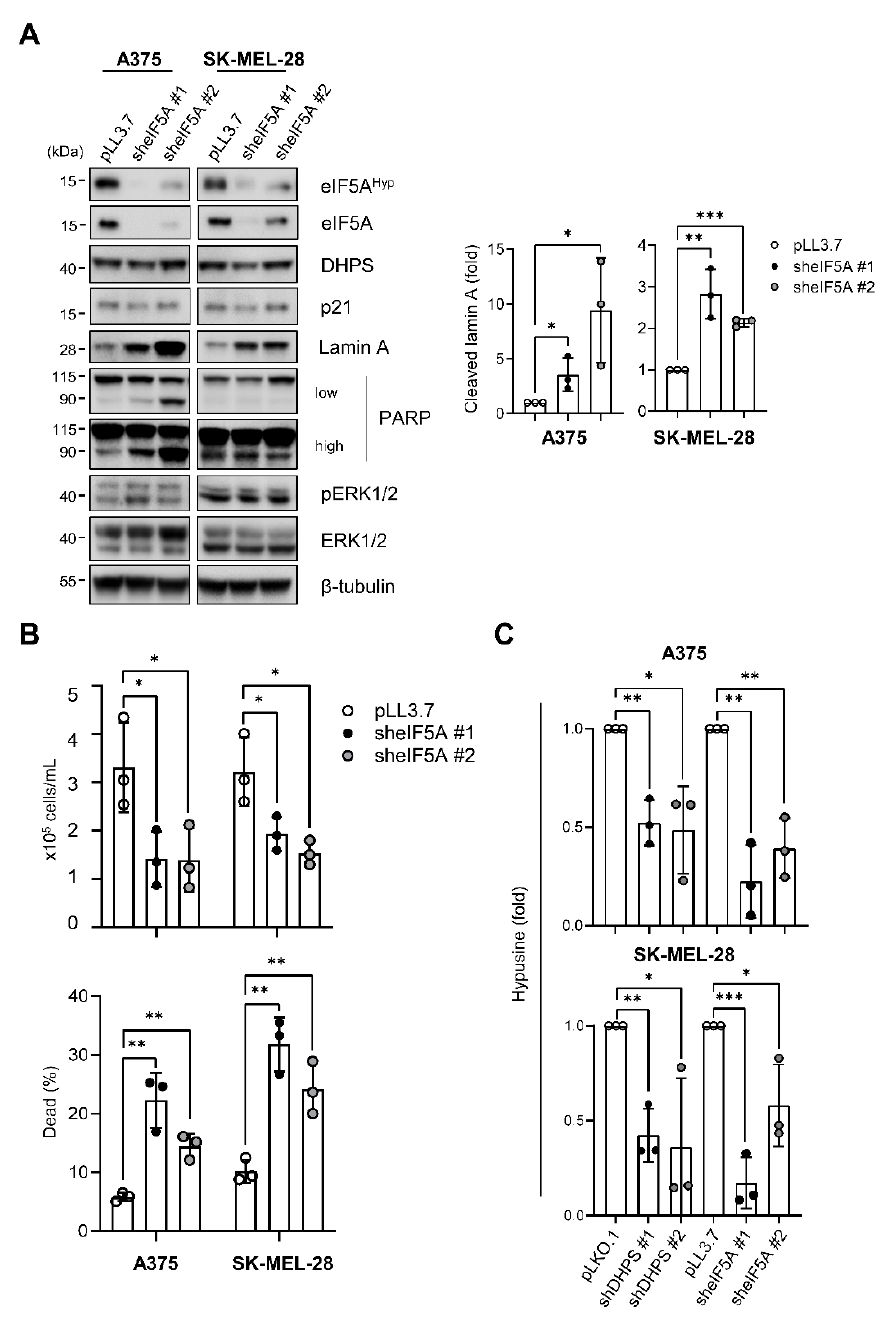
Figure 2. Knockdown of eIF5A induces cell death in A375 andSK-MEL-28 cells. ( A ) Western blots of total lysates of cells infected for 4 days with pLL3.7 viruses expressing shRNA targeting different regions of EIF5A mRNA (sheIF5A #1 and sheIF5A #2). β‐ tubulin is the control for equal protein loading. Empty virus was used as a control. (right) Densitometry of cleaved lamin A normalized to β‐ tubulin. ( B ) Trypan blue exclusion assays to determine viability of cells infected as described in ( A ). ( C ) Densitometry of hypusine from (Figure 1A) and (Figure 2A) normalized to β‐ tubulin. Data are mean ± SD of biological triplicates. * p < 0.05, ** p < 0.005, and *** p < 0.001 by two ‐ tailed Student t ‐ test.